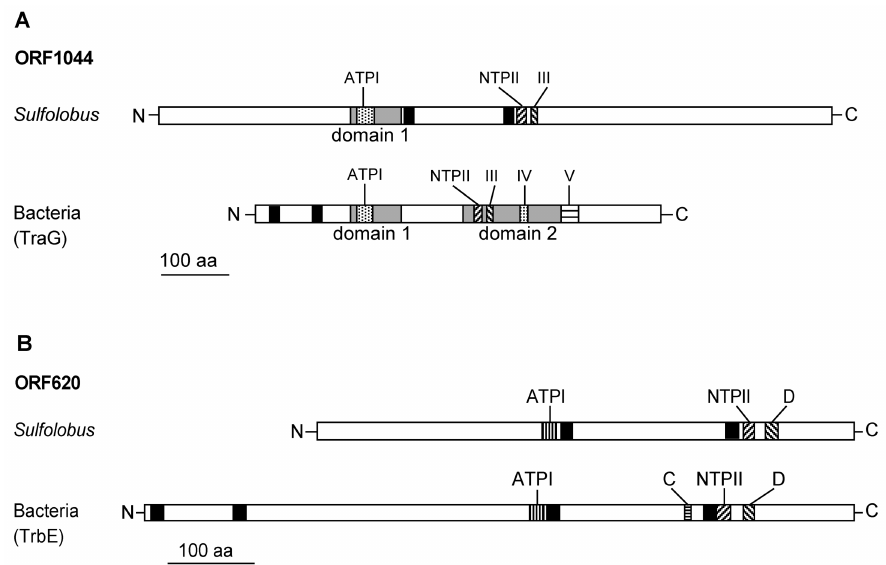
Figure 2. Comparison of motif patterns in ORF1044 and ORF620 of Sulfolobus and the bacterial TraG and TrbE homo- logs, respectively. The conserved domains 1 and 2, and the motifs III, IV and V are labeled. ATPI indicates a Walker A motif and NTPII represents a Walker B mo- tif. Black boxes denote putative transmembrane spanning helices. (A) ORF1044. Conserved do- mains and motifs were identified by alignment of the Sulfolobus ORFs with 19 different bacterial TraG homologs (Schröder et al. 2002). (B) ORF620. Conserved motifs were identified by align- ment with 19 different TrbE homologs of the VirB4 family (Rabel et al.